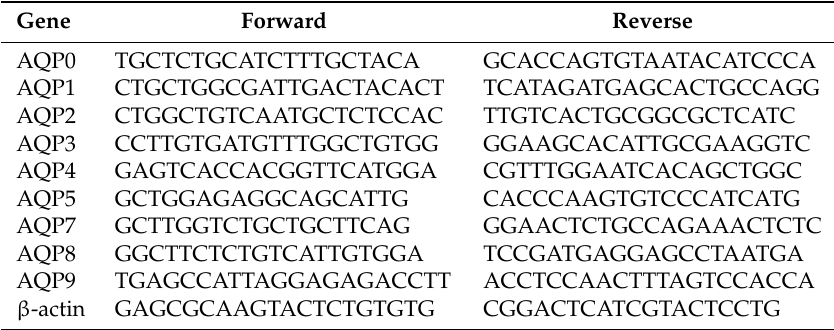
Table 1. Primer sequences for real-time